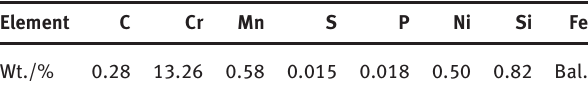
Table 1: Chemical composition of 3Cr13 stainless steel. Element C Cr Mn S P Ni Si Fe